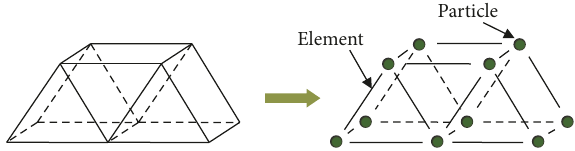
Figure 2: 3D truss structure and discretization in the